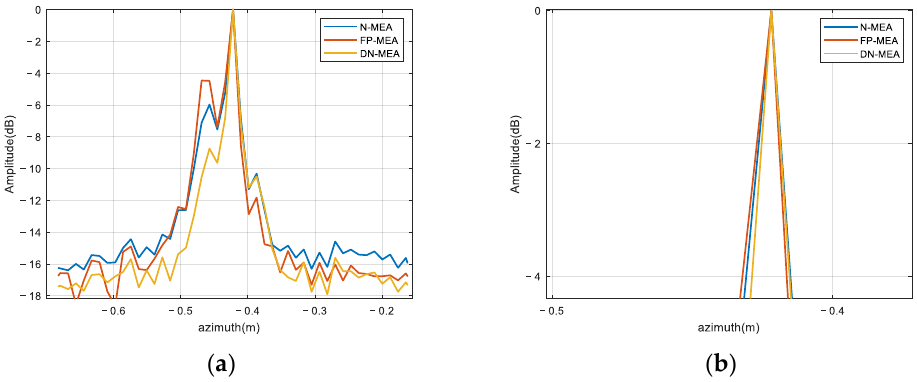
Figure 8. Azimuth profiles of the corner reflector imaging results: ( a ) original results; ( b ) local amplification. Table 3. Quality assessment metrics.